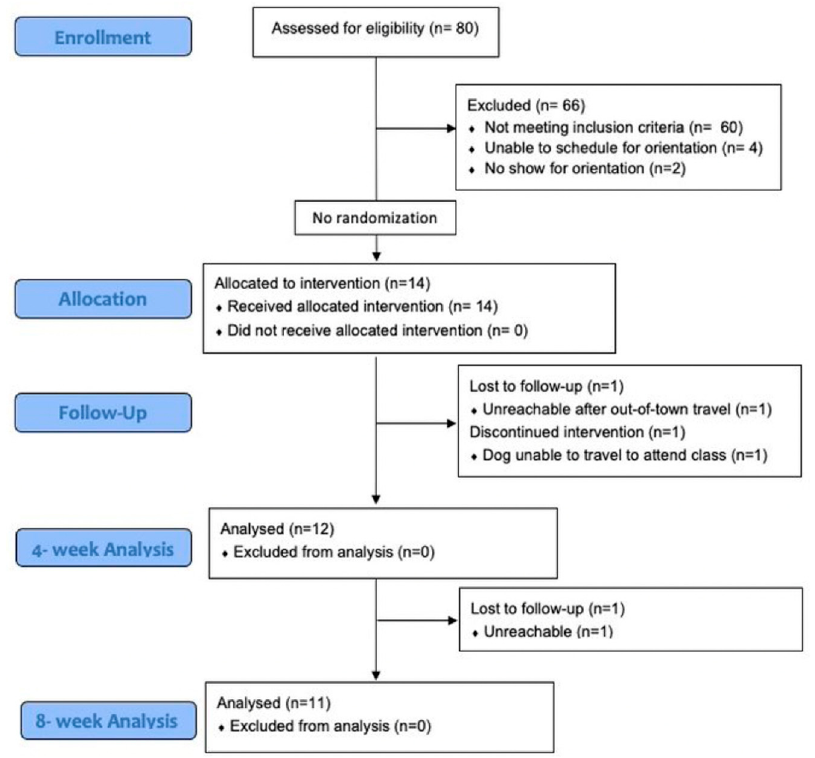
Figure 2. Consort flow diagram.